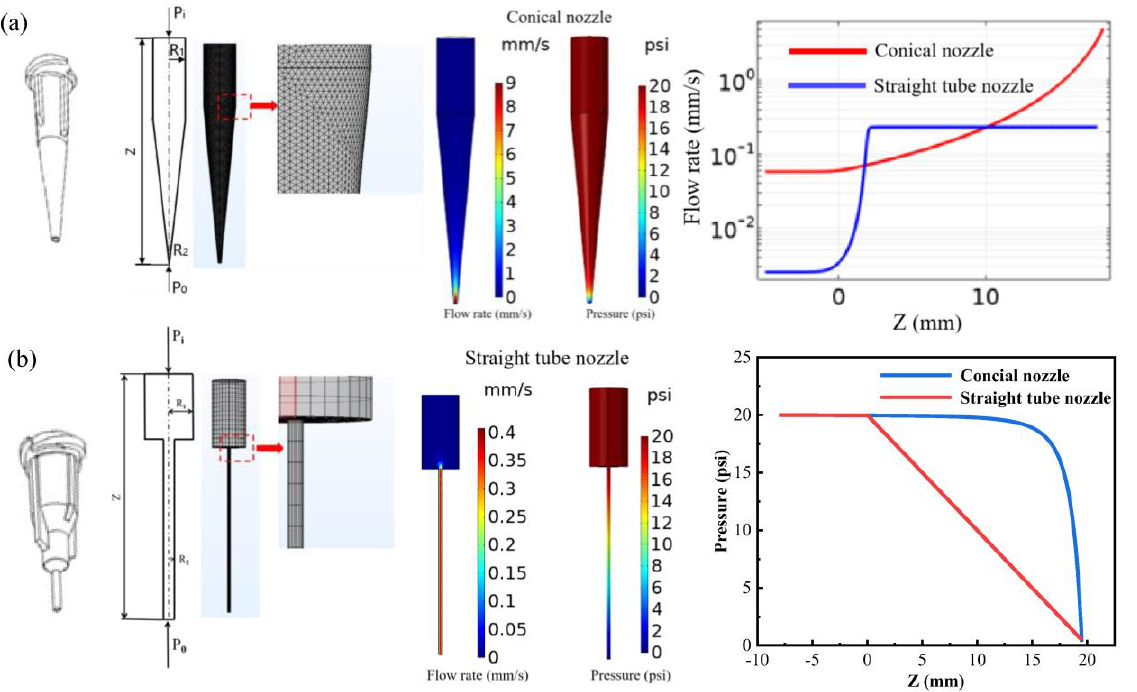
Figure 4. ( a ) The simulation of conical needle and flow rate and pressure simulation diagram; ( b ) the simulation of straight tubular needle and flow rate and pressure simulation diagram.